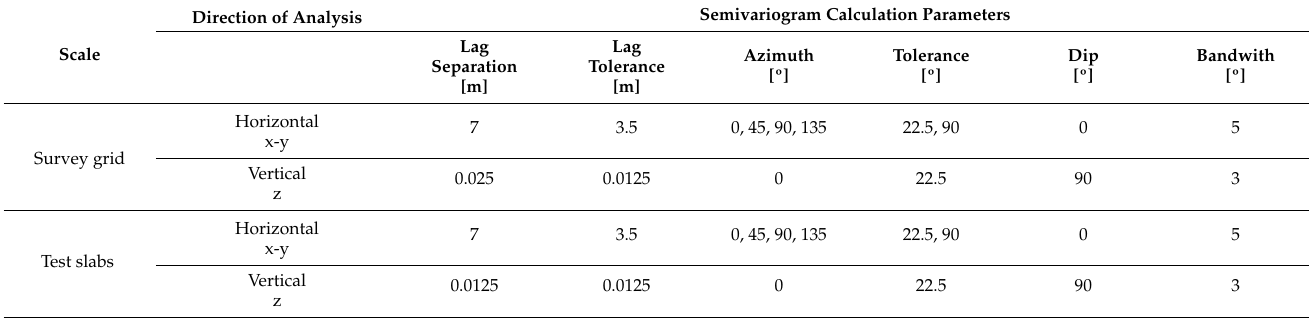
Table 8. Parameters of the experimental semivariograms of q d at a global level using the survey grid and the local level using test